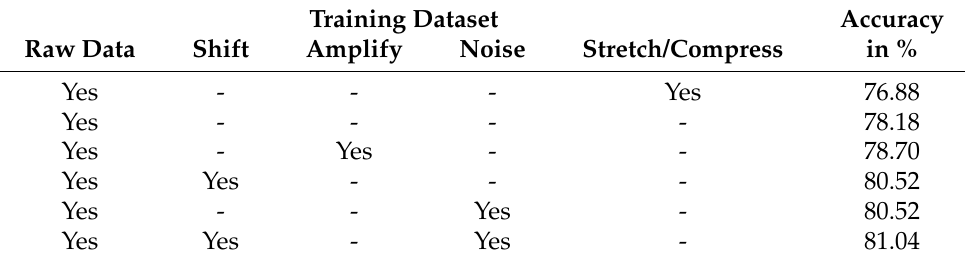
Table 2. Achieved accuracies of audio classification on the test dataset, using different combinations of the training